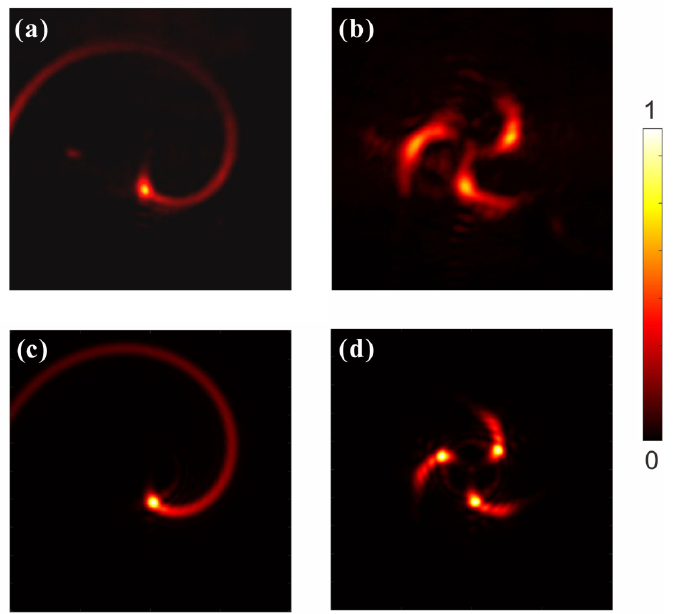
Figure 5. Measured and numerical calculated intensity profiles of MHCBs with parameter ( a , c ) m = 1, α = 6 and ( b , d ) m = 3, α = 6 at the focal plane of the objective